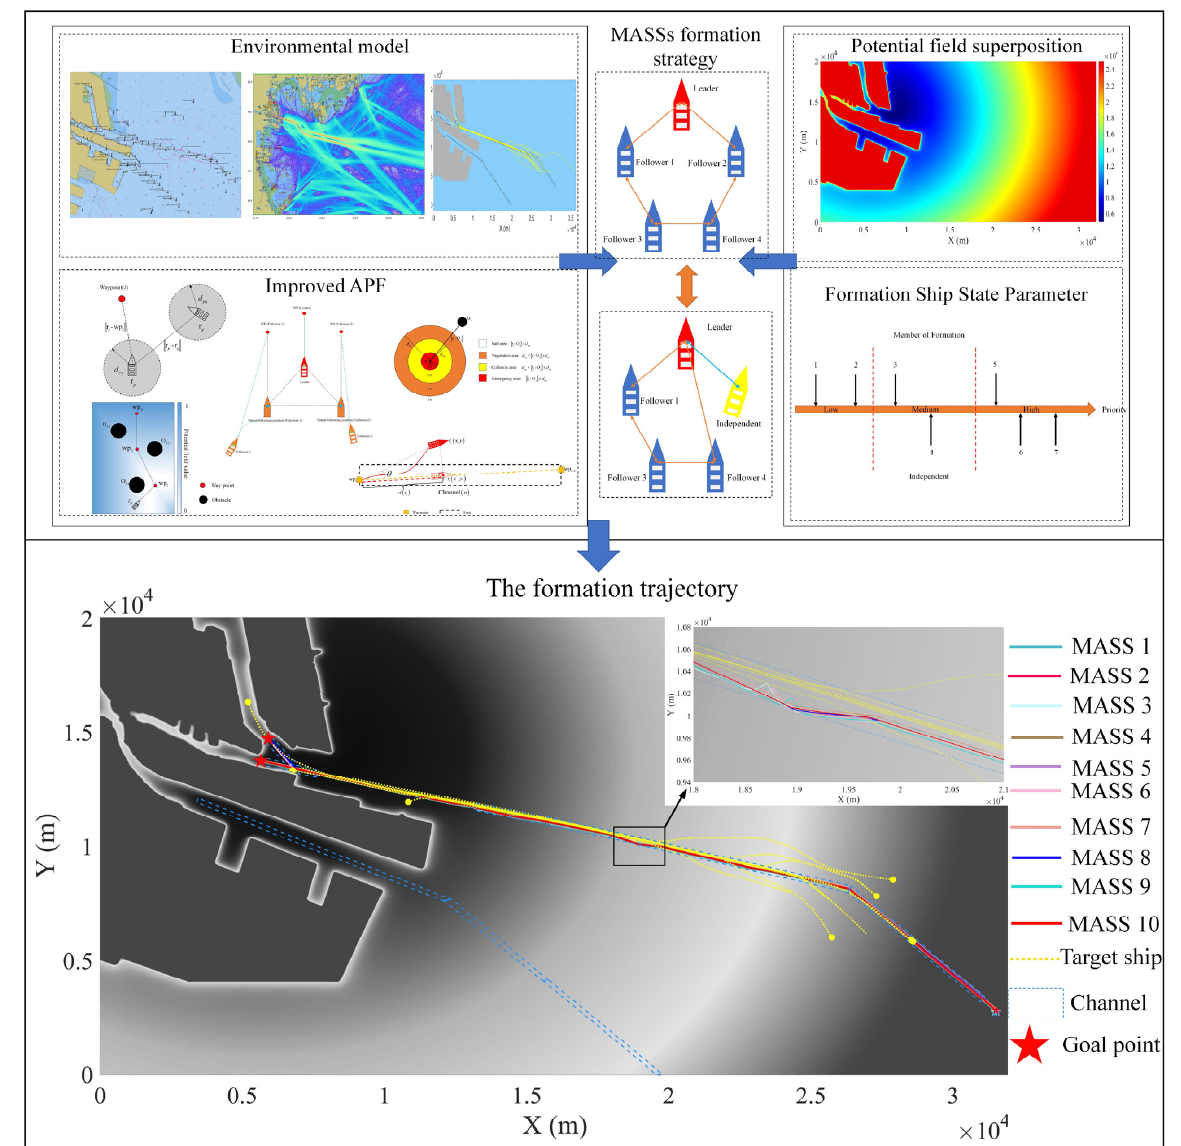
Figure 3. Full text structure diagram.